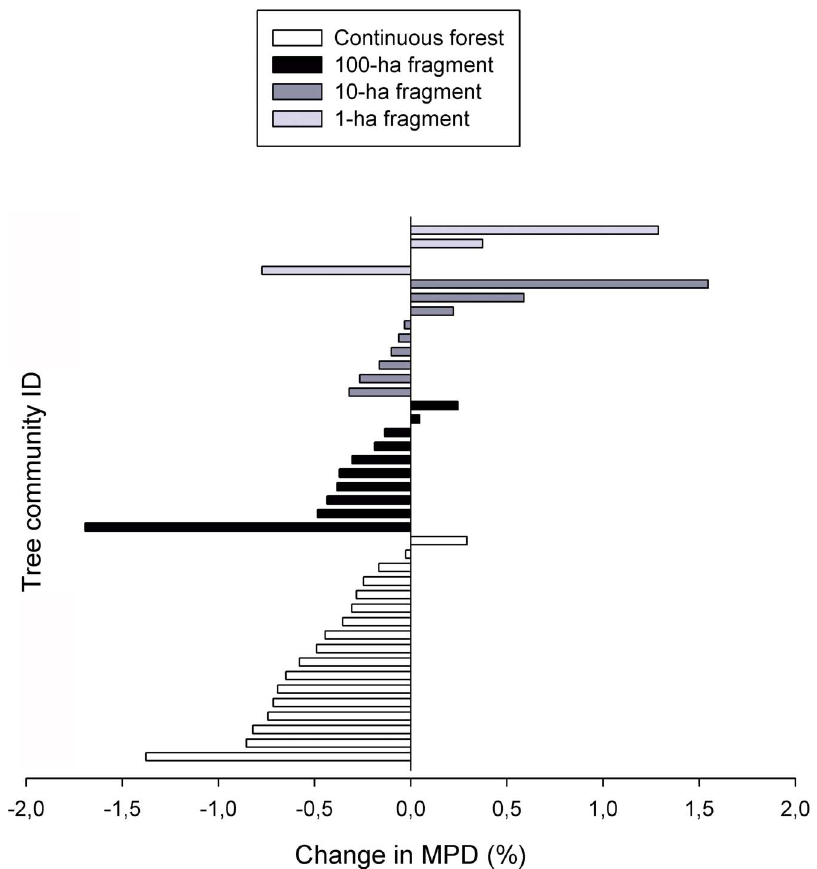
Figure 2. Relative change in mean phylogenetic distance across 40 tree communities in a 1000-km 2 forest landscape of Central Amazonia, Brazil. Negative values indicate loss of phylogenetic diversity over time.